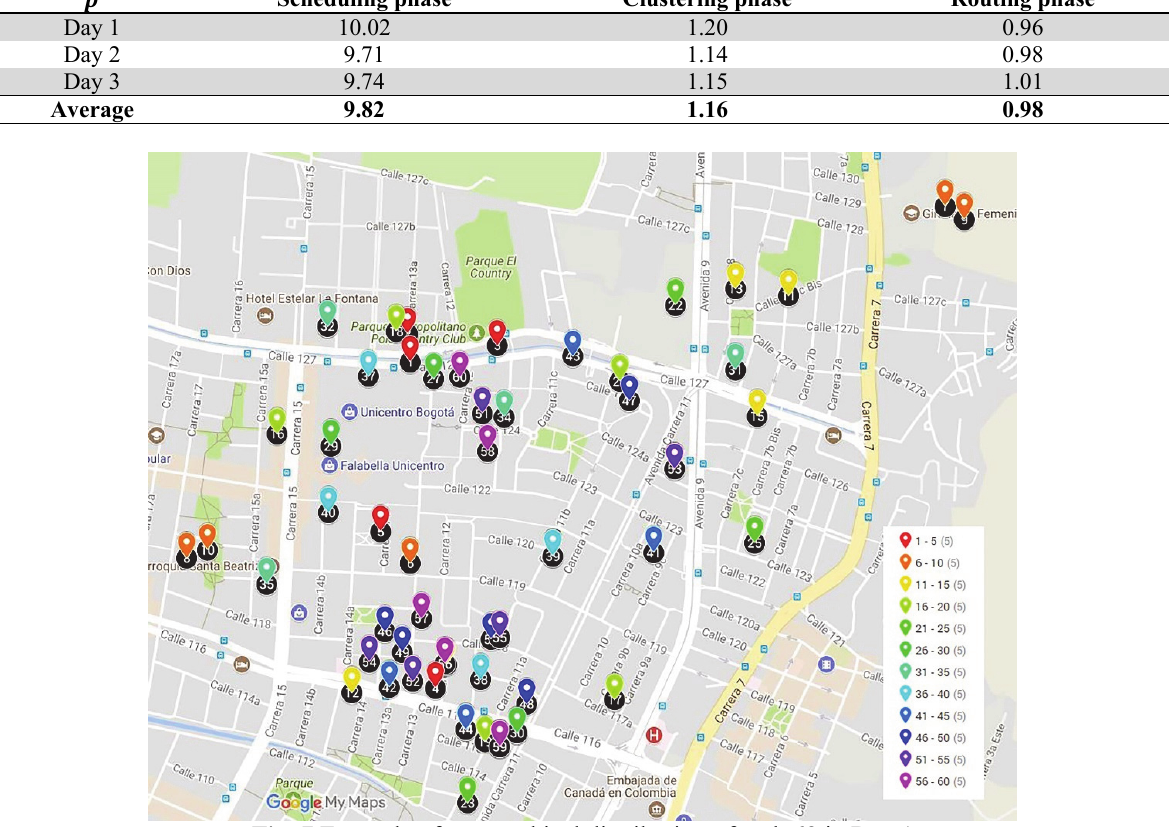
Fig. 7 Example of geographical distribution of path 68 in Day